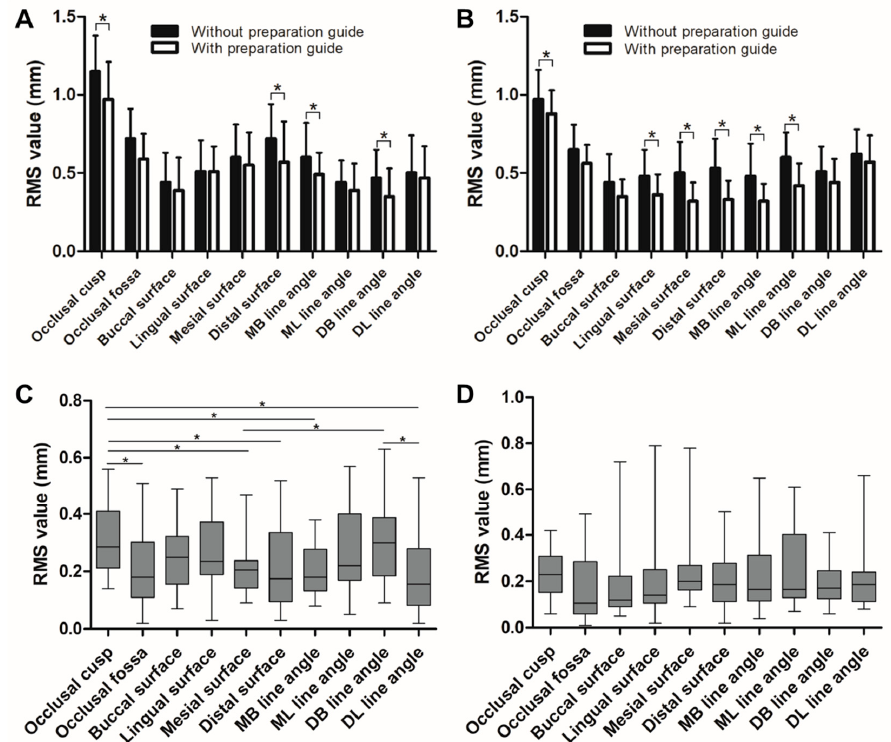
Figure 7. Comparisons of amount of tooth reduction: ( A ) root mean square (RMS) values for maxillary primary first molars, ( B ) RMS values for mandibular second molars, ( C ) di ff erences in the amount of tooth reduction in maxillary primary first molars based on guide usage, and ( D ) di ff erences in the amount of tooth reduction in mandibular second molars based on guide usage. Statistical significances are not observed among the surfaces and line angles. MB = Mesiobuccal, ML = Mesiolingual, DB = Distobuccal, DL = Distolingual; *statistically significant ( p <